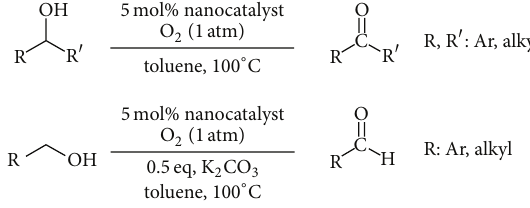
Scheme 1: Fe-V/SiO 2 catalyzed oxidation